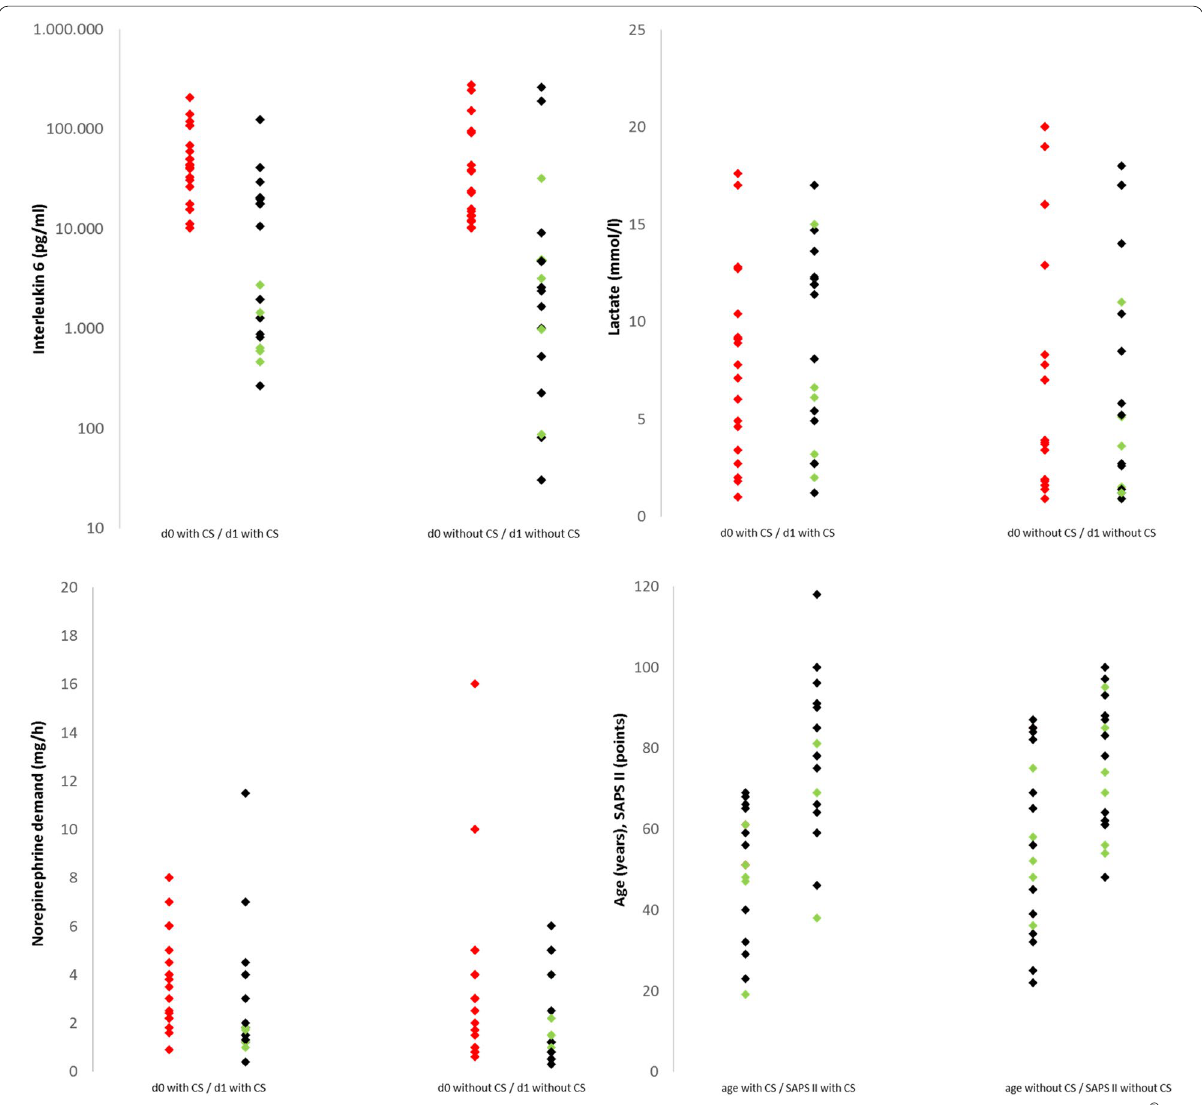
Fig. 2 Interleukin-6, lactate and norepinephrine demand on day 0 and day 1, and SAPS II and age on d0 in patients with and without CytoSorb ® therapy. green dots, patient survived; black dot, patient died in the hospital; CS, CytoSorb ® ; SAPS, Simplified Acute Physiology Score; CRP, C-reactive protein; d0, 0–12 h before starting CS therapy (group 1) or the measured IL-6 > 10,000 pg/ml (group 2); d1, 12–24 h after starting CS therapy (group 1) or 12–24 h after d0 IL-6 (group 2); Nor,